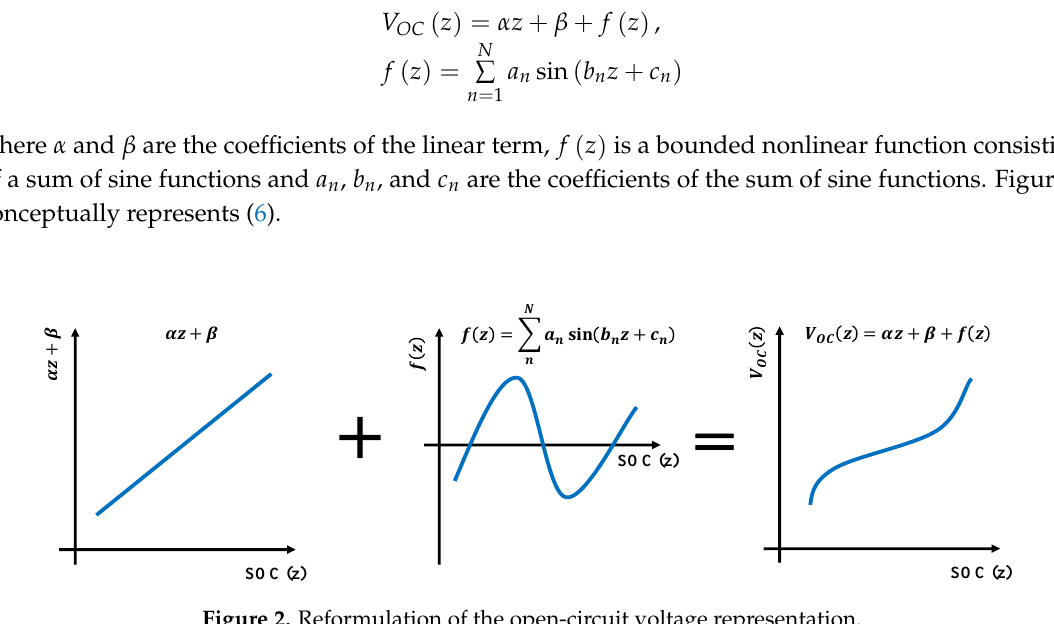
Figure 2. Reformulation of the open-circuit voltage